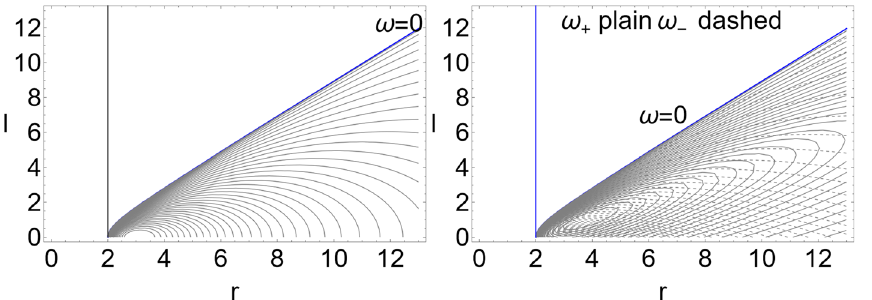
Fig. 5 Left panel: NUT1-solution of Eq. (15). Metric bundles are rep- resented in the plane l − r , where l is the NUT-parameter, and on the equatorial plane θ = π/ 2. The horizon is also represented for ω = 0.